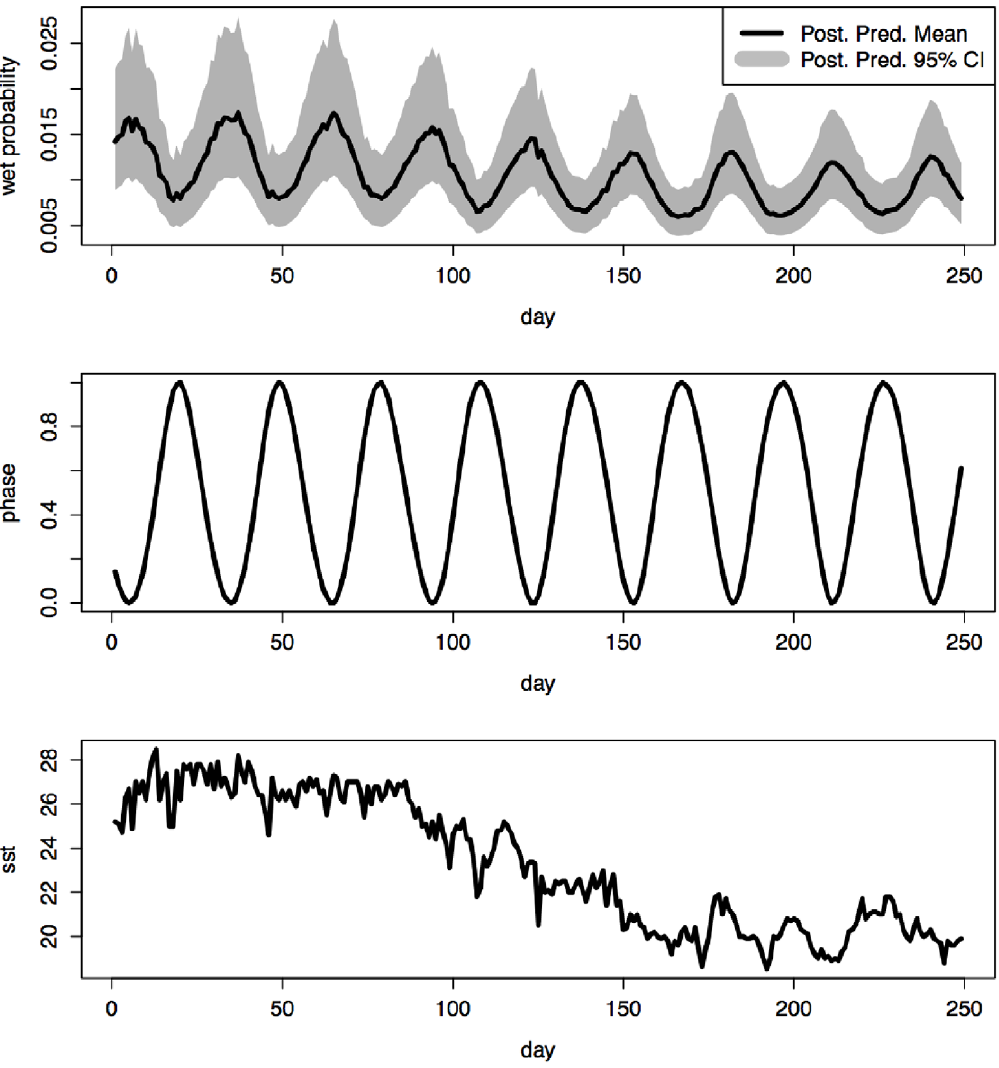
Figure 6. Posterior predictive distribution for p (probability of wet) for each of the nights of data collection. The grey area represents the posterior predictive 95% credible interval for this quantity while the solid line represents the posterior predictive mean. Bottom two panels represent moon phase and SST, respectively. Numbers above represent the month of the year, vertical grey lines separate each month accordingly.